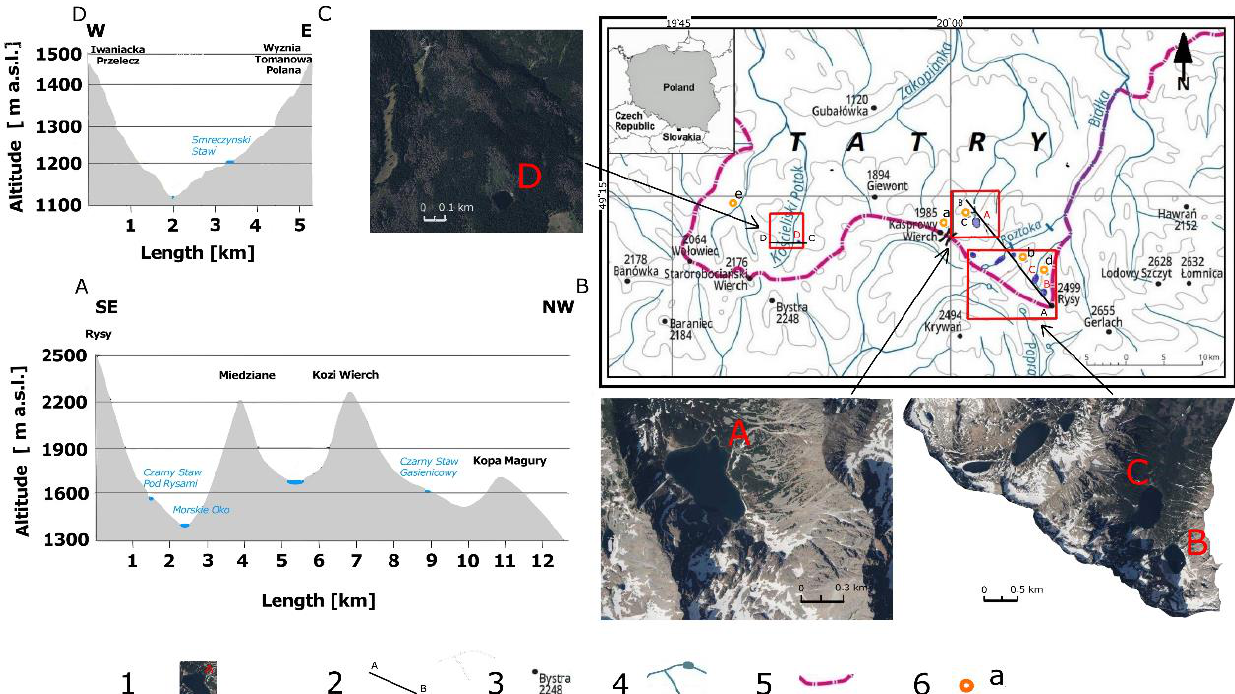
Figure 1. Location of the studied lakes in the Tatra Mountains: 1—lakes covered by studies of ice phenomena (A—Czarny Staw G ˛asienicowy; B—Czarny Staw pod Rysami; C—Morskie Oko; D— Smreczy´nski Staw); 2—relief profiles; 3—major peaks; 4—surface hydrographic network; 5—state borders; 6—meteorological stations (a—on the Kasprowy Wierch; b—in the Dolina Pi˛eciu Staw ó w Polskich; c—on the Hala G ˛asienicowa; d—in the Dolina Rybiego Potoku by the Morskie Oko mountain shelter; e—on the Polana Chochołowska). Table 1. Major morphometric parameters of the Tatra lakes selected for the study. Lake Altitude (m